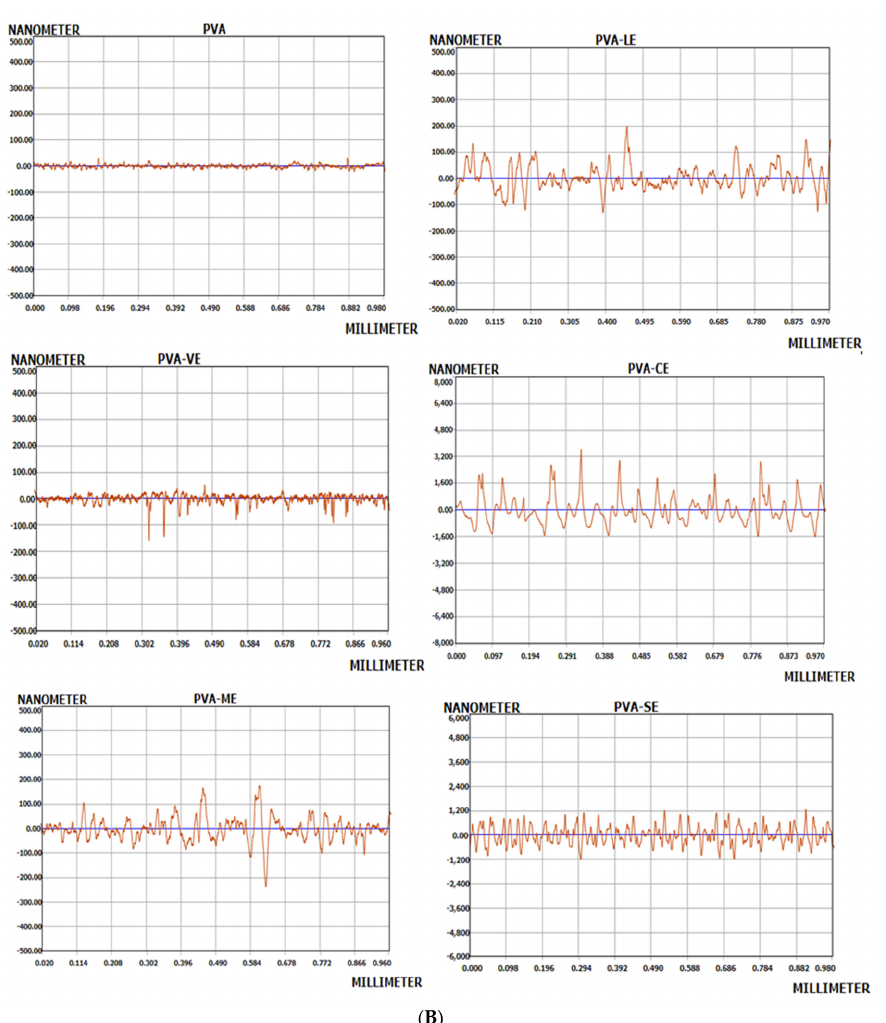
Figure 5. (A) Surface morphology analysis with Raman confocal microscope images PVA (a); PVA-VE (b); PVA-ME (c); PVA-LE (d); PVA-CE (e); PVA-SE (f) and (B) Profiler roughness measurements. Table 3’s footer: “ (–) No activity, (+) Weak activity, (++) Good activity,(+++ and ++++) Very good activity. ” Should be added.